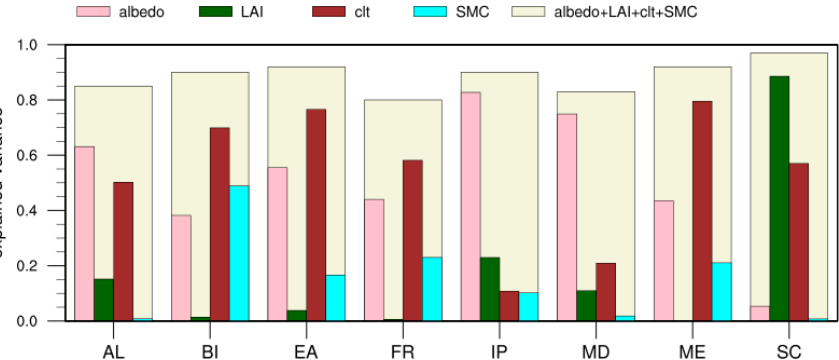
Figure 10. The fraction of inter-model variance in AAST response (FOREST minus GRASS) explained by mean summer changes in albedo, LAI, cloud fraction (clt), SMC or all combined (albedo + LAI + clt + SMC). Bars represent the coefficient of determination ( R 2 ) values derived from linear regression analysis applied over each subregion: Alps (AL), British Isles (BI), eastern Europe (EA), France (FR), Iberian Peninsula (IP), Mediterranean (MD), mid-Europe (ME), Scandinavia